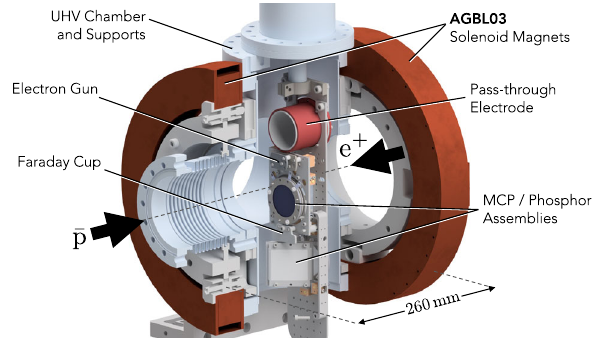
FIG. 6. Simplified schematic showing a cross section of the positron diagnostics station (PDS). The central UHV chamber and surrounding support structures are shown in light blue, while magnet windings are highlighted in orange.